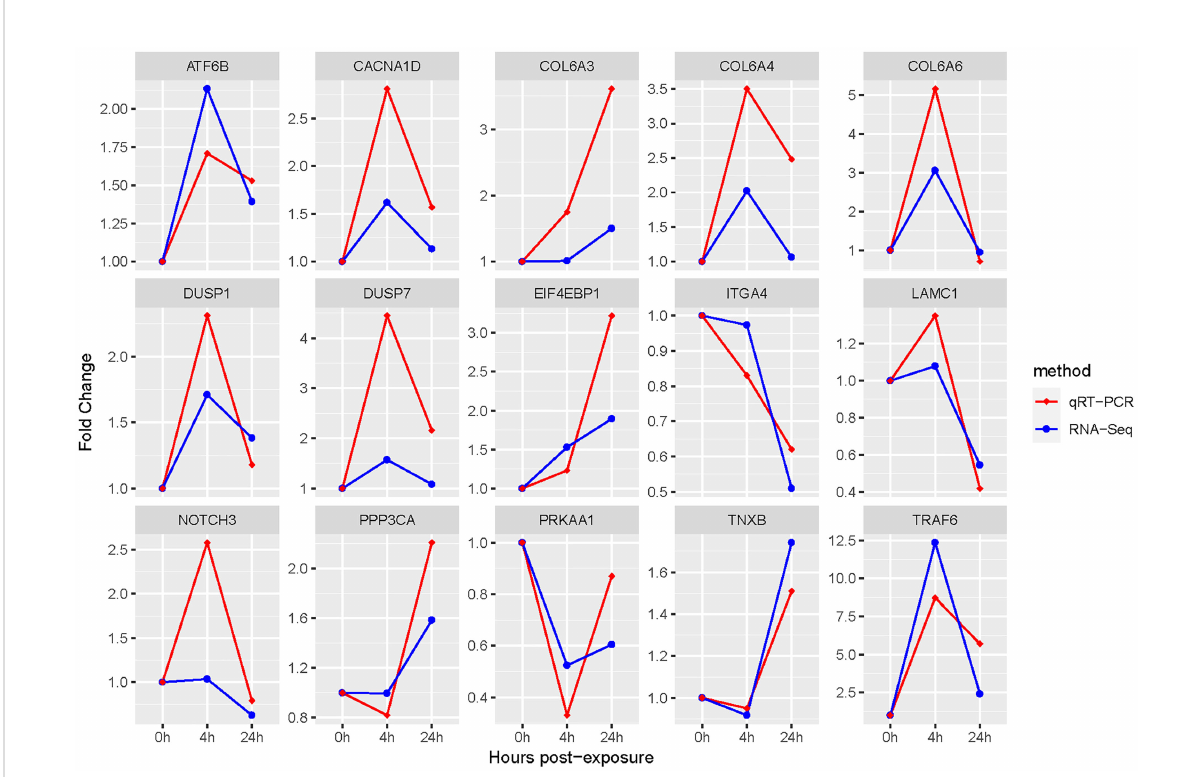
FIGURE 7 qRT-PCR and RNA-Seq results of key DEGs. The b -actin gene is used to normalize the gene expressions of qRT-PCR and RNA-Seq. The abscissa stands for the exposed time of Cd and Cu; the ordinate indicates fold